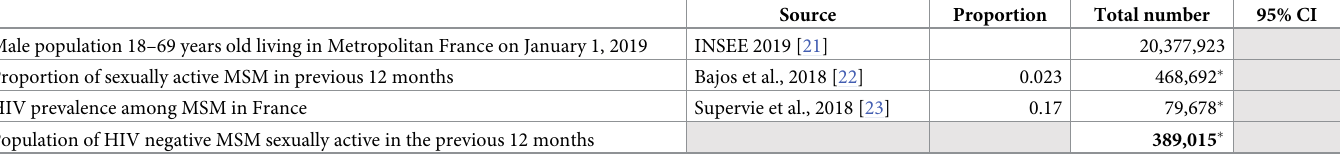
Table 2. Estimation of number of HIV-seronegative MSM in France sexually active in the previous 12